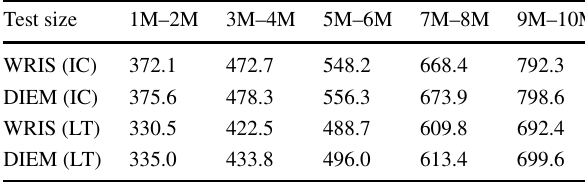
Table 4 Targeted influence spread when varying test graph size